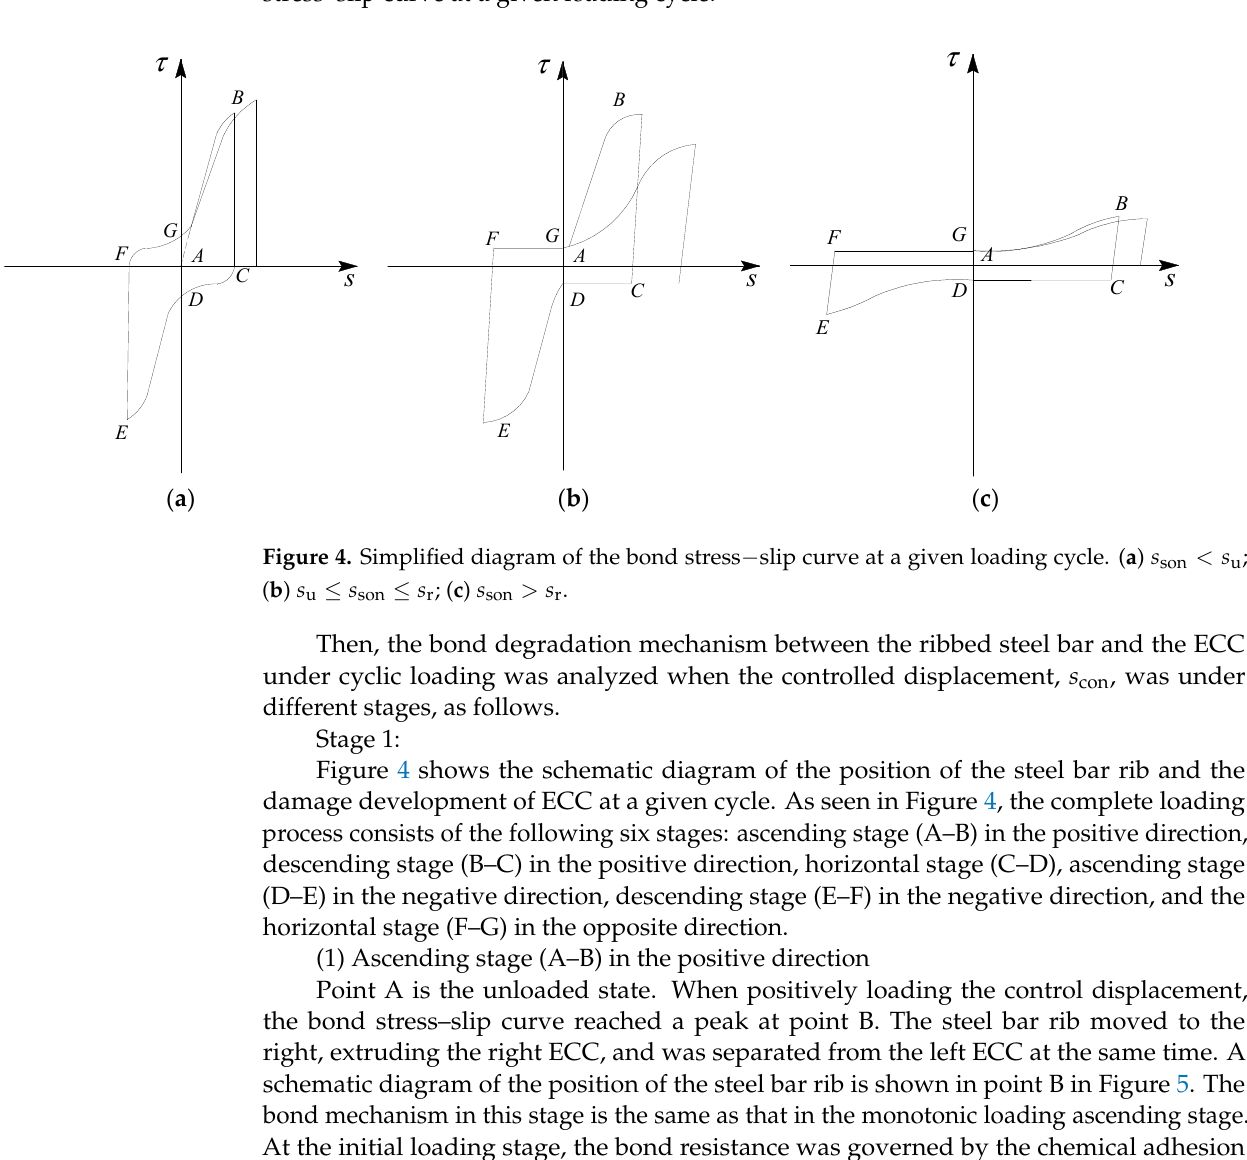
horizontal stage (F–G) in the opposite direction. (1) Ascending stage (A–B) in the positive direction Point A is the unloaded state. When positively loading the control displacement, the bond stress–slip curve reached a peak at point B. The steel bar rib moved to the right, extruding the right ECC, and was separated from the left ECC at the same time. A schematic diagram of the position of the steel bar rib is shown in point B in Figure 5.